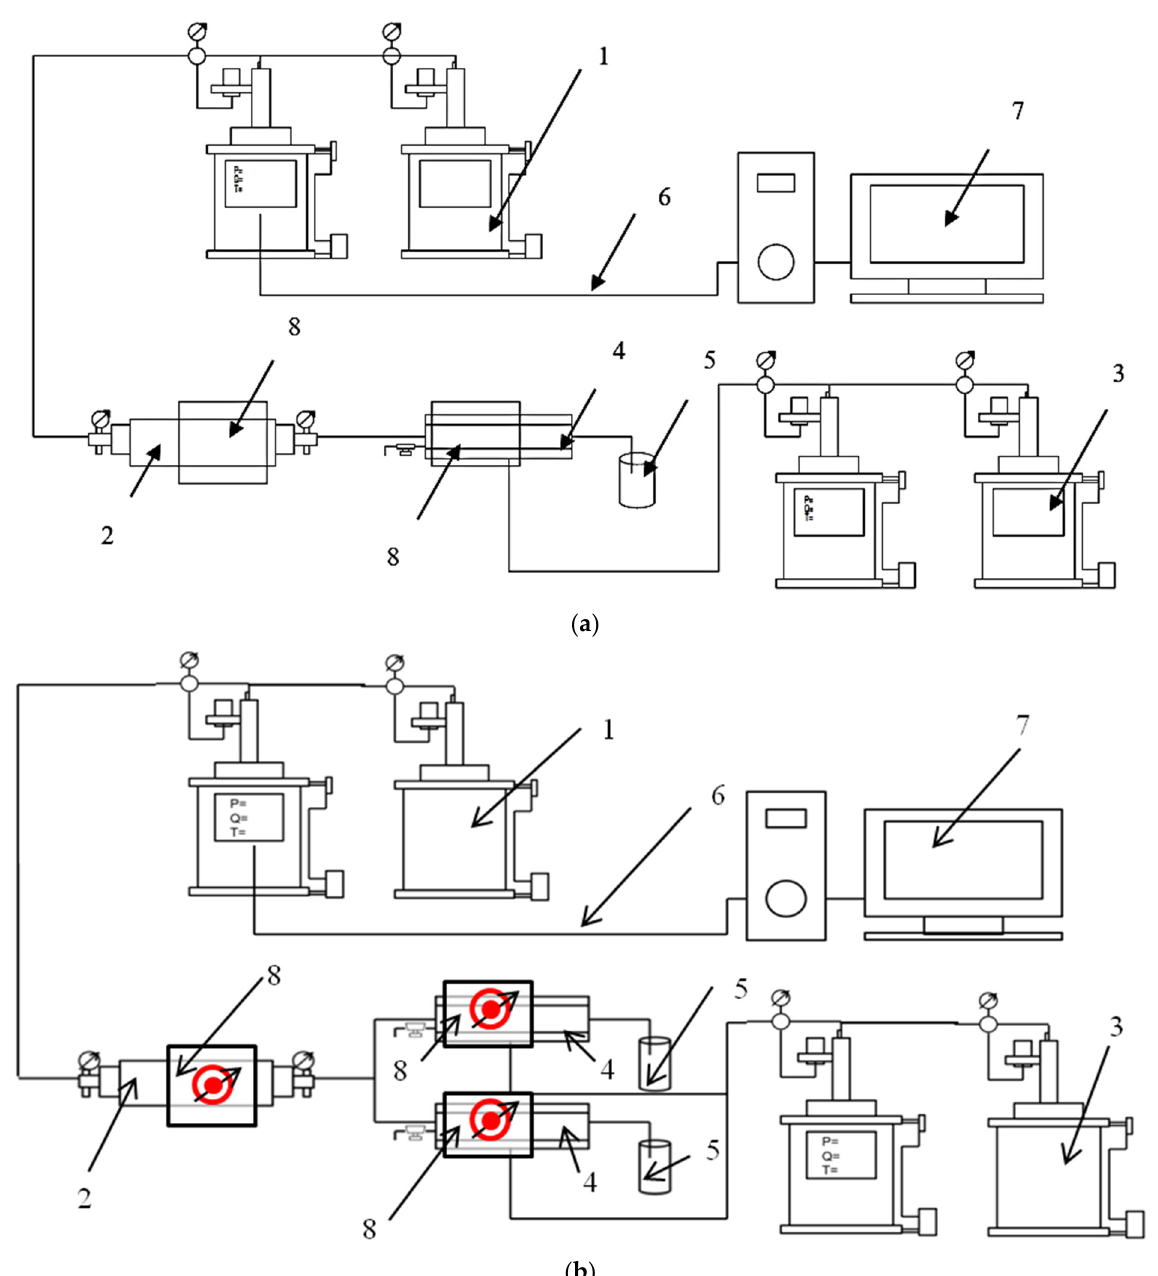
Figure 4. Schematic diagram of the core flooding test with a single core model ( a ) and the core flooding unit for the testing conditions in the heterogeneous reservoirs ( b ). 1—injection pump; 2—sampler; 3—clamping system; 4—core holders; 5—measuring containers; 6—tubes and fittings made of Hastelloy; 7—computer with a program for recording and adjusting the pump operation parameters; 8—heated casing for the sampler and the core holder.